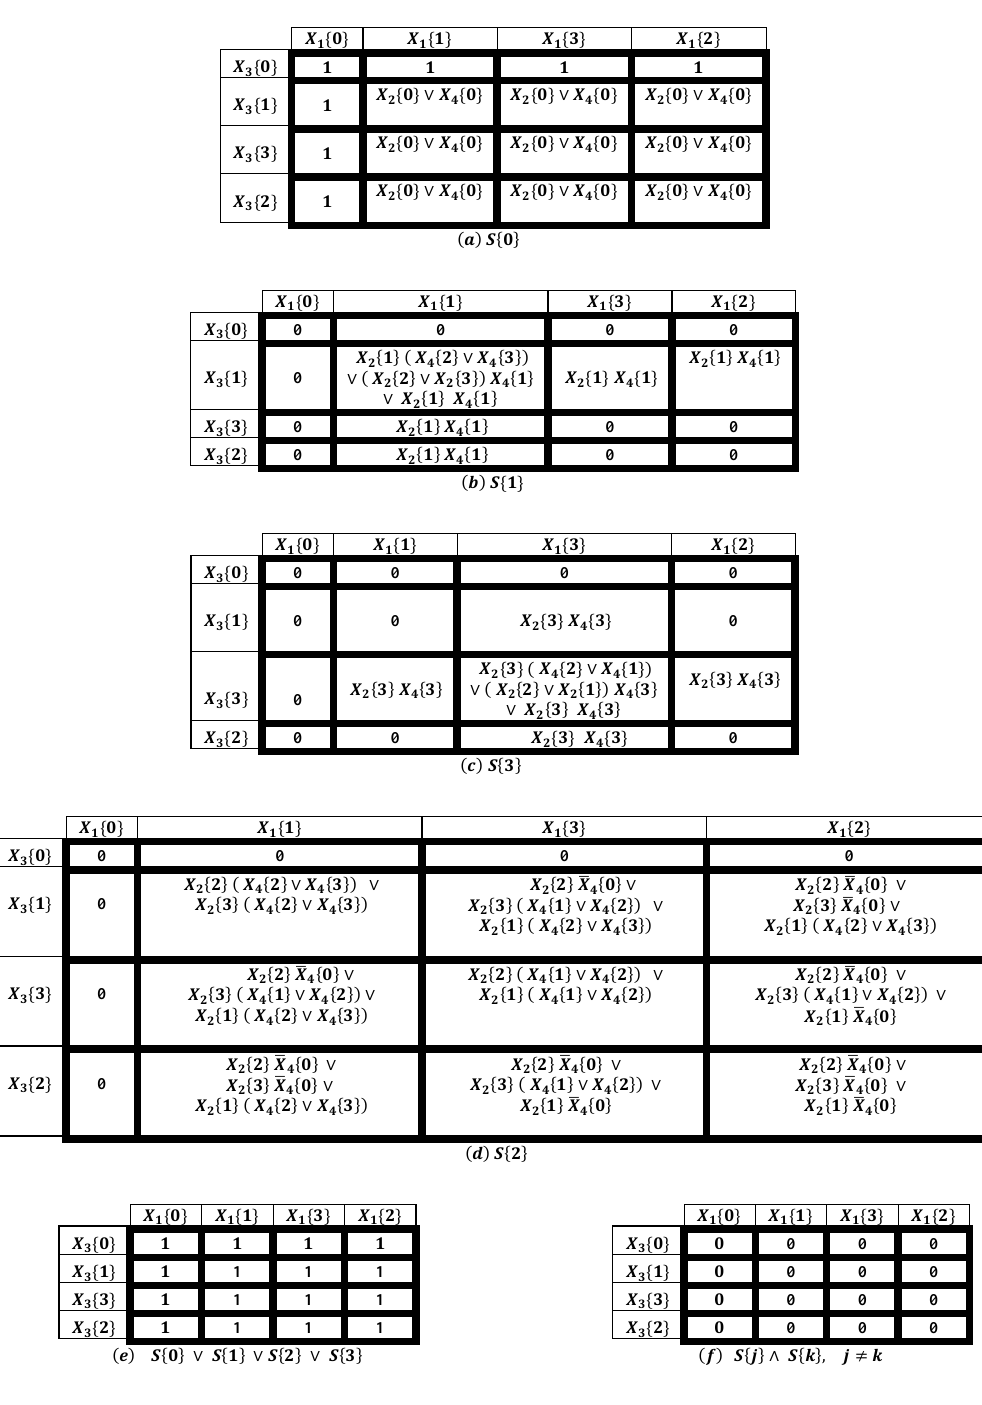
Figure 2. Variable-entered Karnaugh maps representing the four instances of the four-valued output variable and verifying their